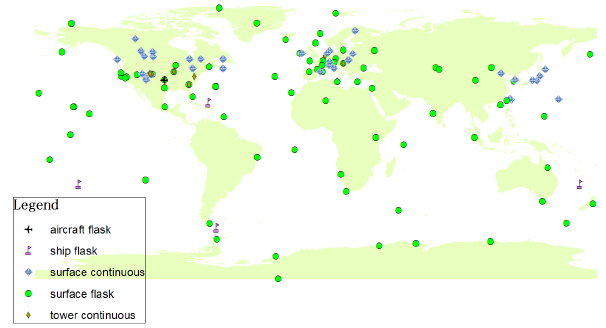
Figure 3. The observational sites used in this study.